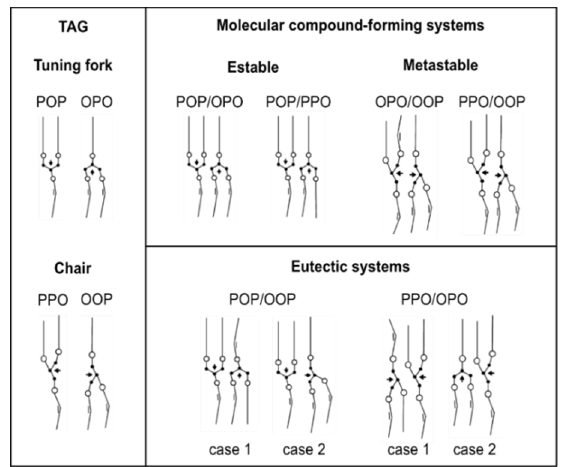
Figure 8. Proposed structural models for saturated- cis -unsaturated TAGs and their binary mixtures. Reprinted with permission from [130], © 2015 American Chemical Society.